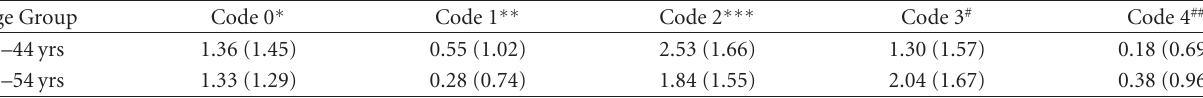
Table 2: Mean number (SD) of sextants a ff ected by periodontal conditions in various age groups.